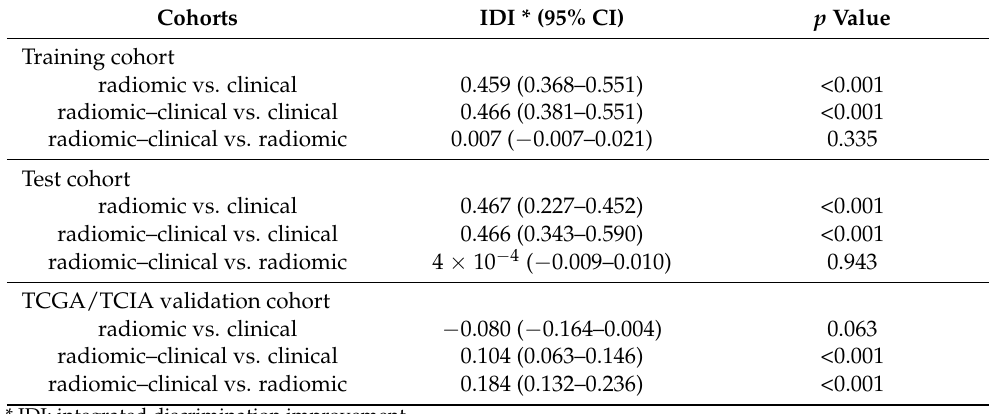
Table 3. Evaluation results of IDI in the un-SMOTE training cohort, test cohort and independent TCGA/TCIA validation cohort.